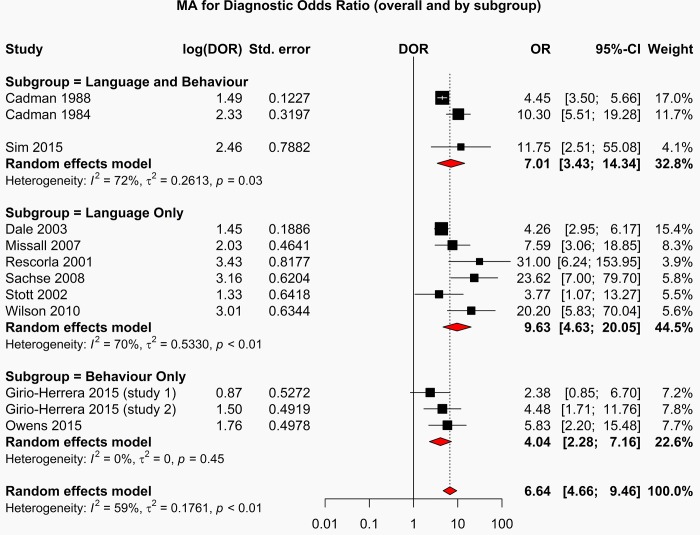
Diagnostic odds ratios forest plot.